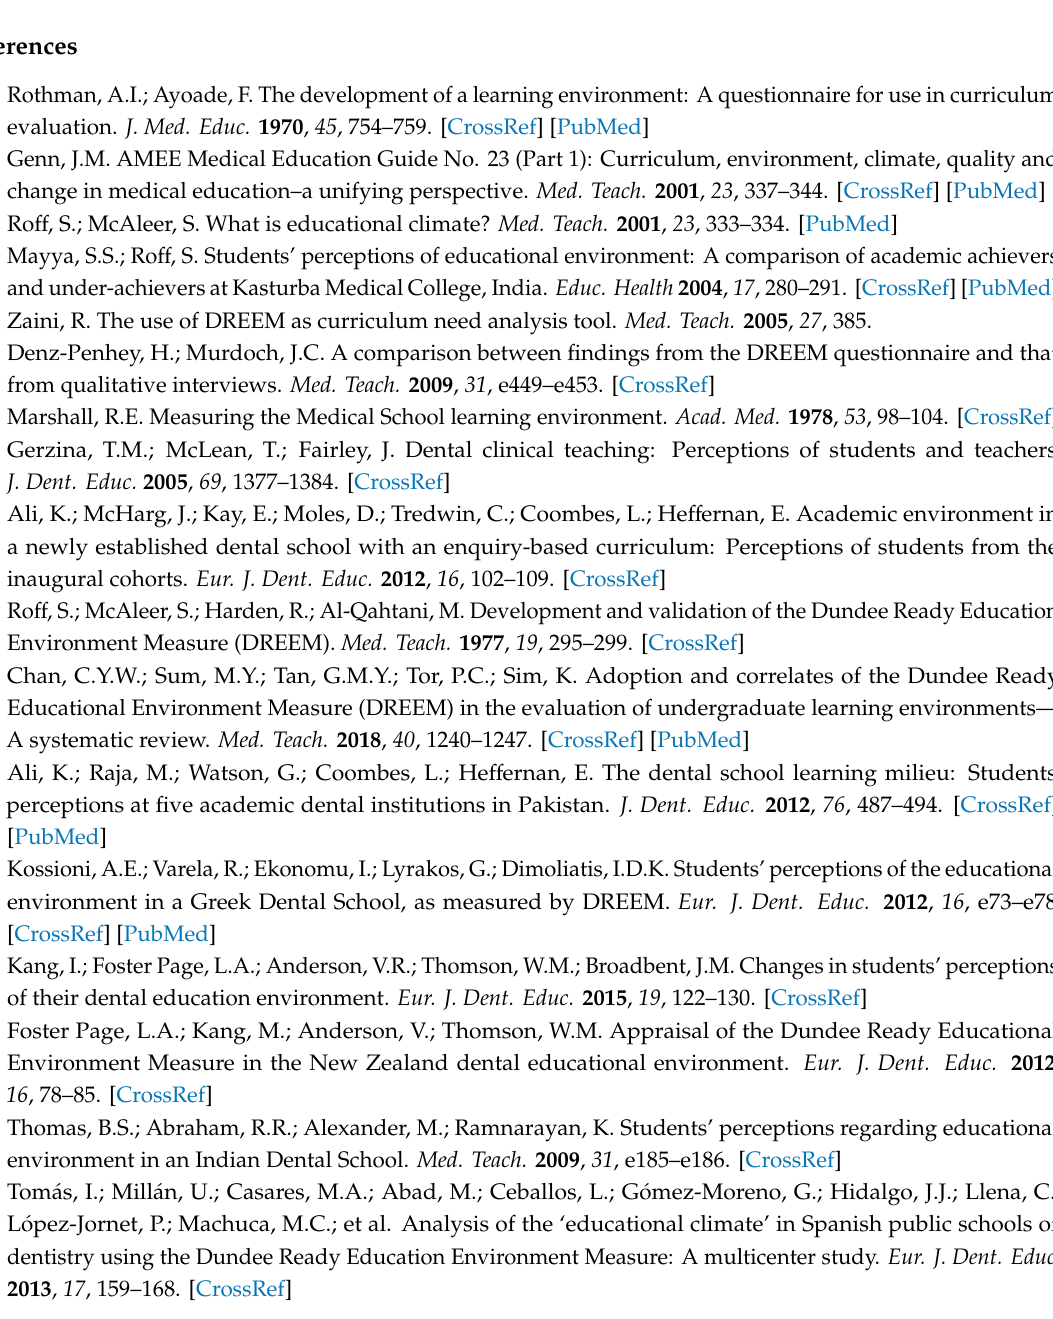
Table S1: Dundee Ready Education Environment (DREEM) questionnaire (50 items). Table S2: Mean values of the items with statistically significant di ff erences with respect to the academic